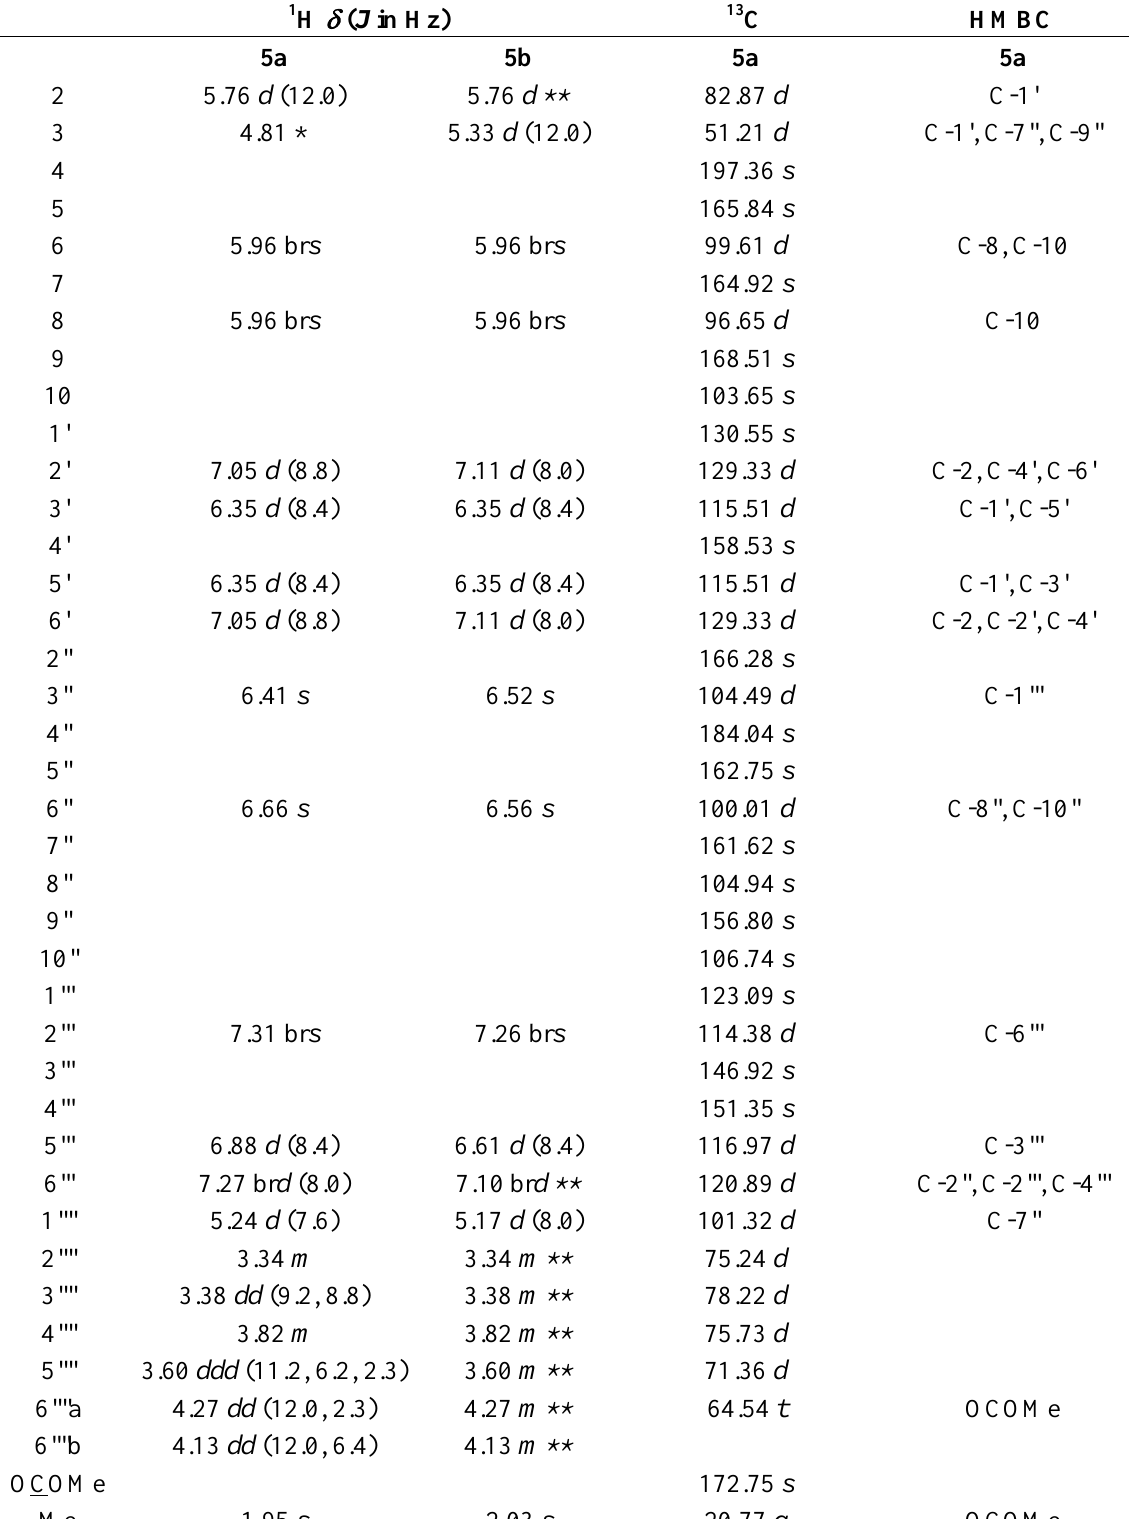
Table 1. 1 H-NMR, 13 C-NMR, and HMBC data of compound 5 in CD